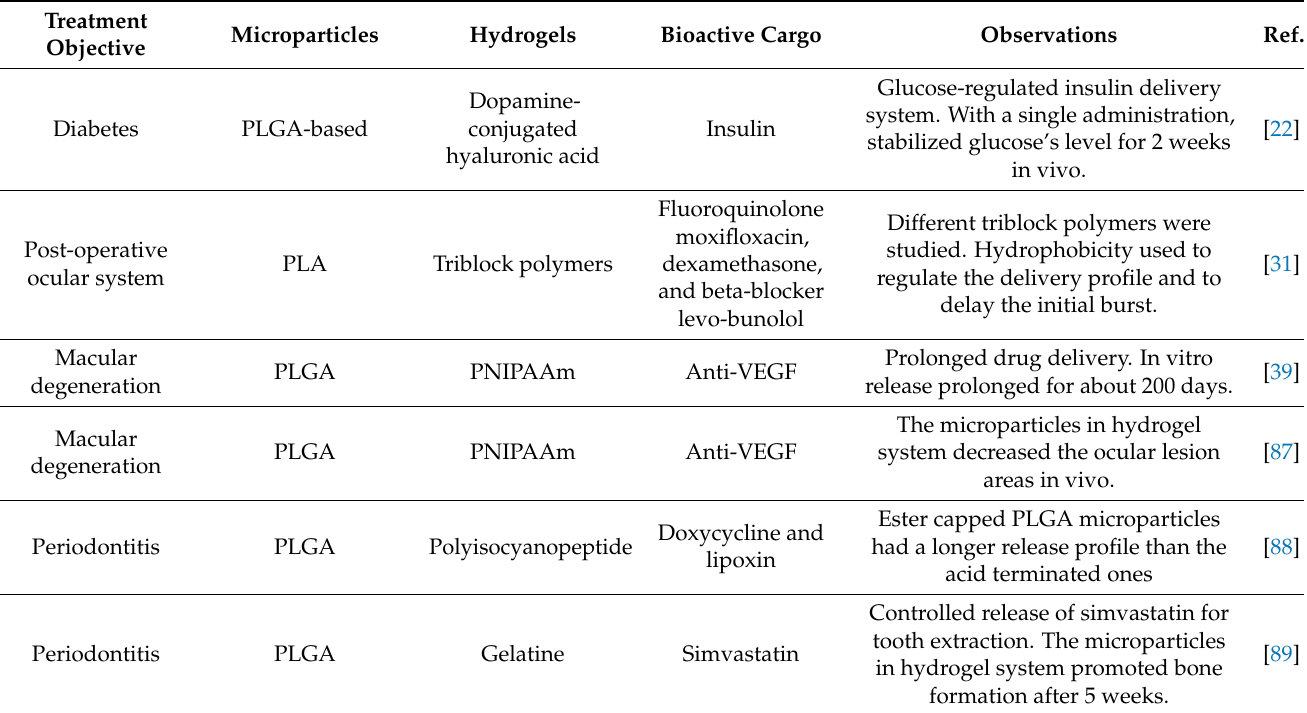
Table 7. Microparticles in hydrogel system application in diverse